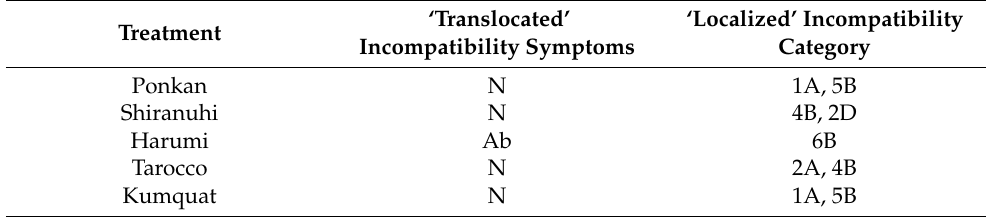
ing (refer to Table 1).